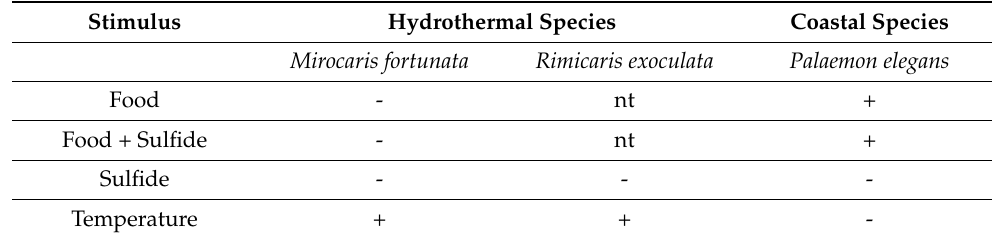
Table 1. Responses to odor and temperature stimuli for hydrothermal and coastal shrimp species. +, attraction; -, no attraction observed; nt, not tested. The food odor source can be a mussel extract or a shrimp food extract. The concentration of sulfide (Na 2 S) is 2 mmol L − 1 . The temperature source is approximately 17 ◦ C in ambient water at 9 ◦ C. Stimulus Hydrothermal Species Coastal Species Mirocaris fortunata Rimicaris exoculata Palaemon elegans Food - nt + Food + Sulfide - nt + Sulfide - - - Temperature + +